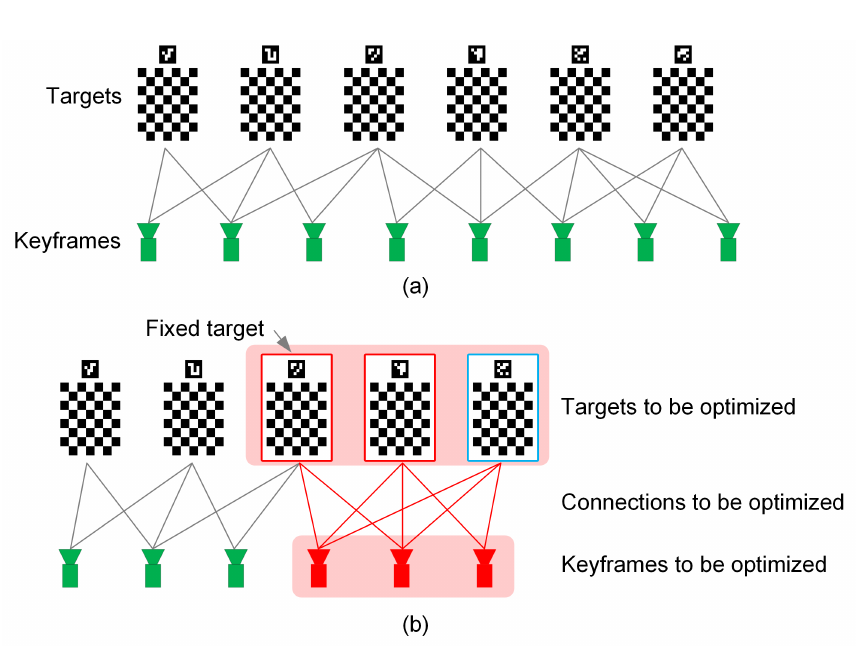
Figure 4. Networks between targets and keyframes. ( a ) global network; ( b ) local